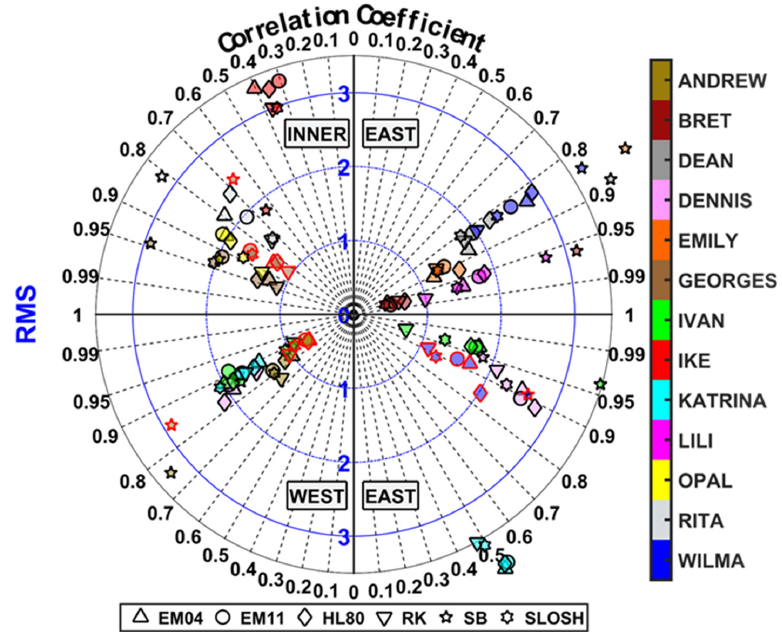
Figure 8. Circular diagram of root mean square error (RMS) (blue concentric circles) and correlation coefficient (CC) (radial black dotted lines) calculated from the resulting Hs covering 24 h before and after the TC crosses a particular buoy (shown by different symbols). The results are grouped in different quadrants according to the location of the buoy relative to the TC center (inner region when the buoy is located at less than one R mw , and east and west depending on the buoy position with respect the translation direction of the TC). The events corresponding to Georges for buoy 42040 (inner region), Wilma for buoy 42057 (east) and Andrew for buoy 42001 (west) are represented with a red edge color to differentiate them at the buoys 42003, 42056 and 42003 respectively (black edge color). The SB model results for Katrina in buoy 42001 and Emily in buoy 42056 do not appear as they have very high RMS values and are outside the plot limits (RMS = 4.52; 4.31 and CC = 0.89; 0.85 respectively).